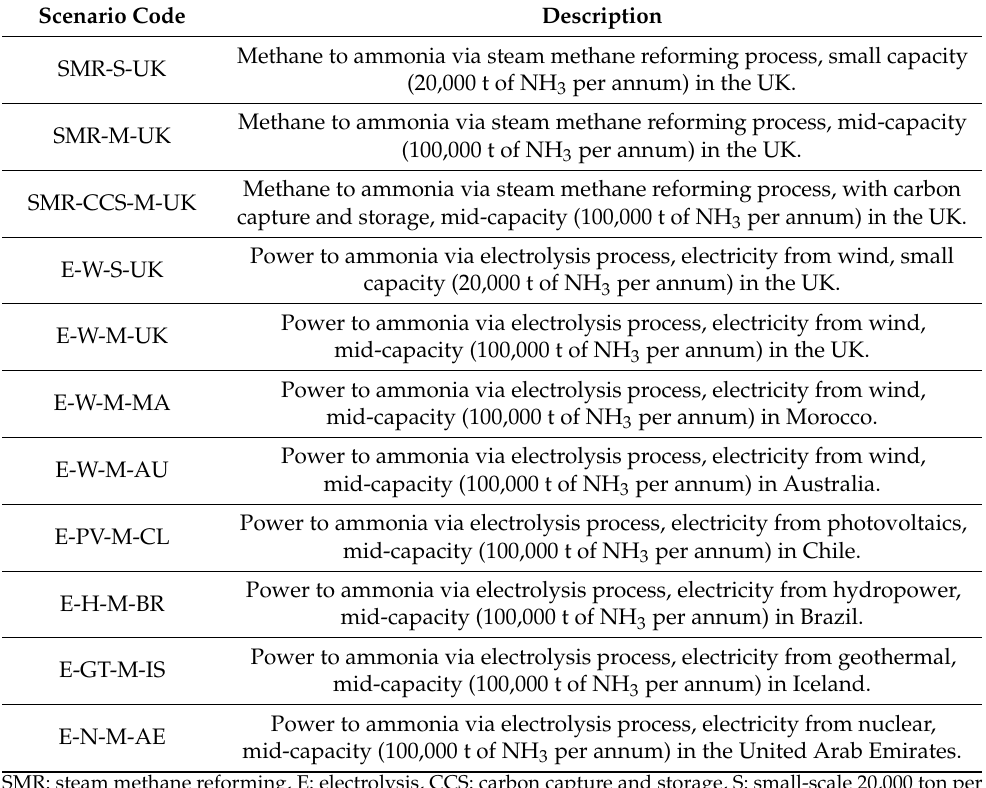
Table 2. Description of